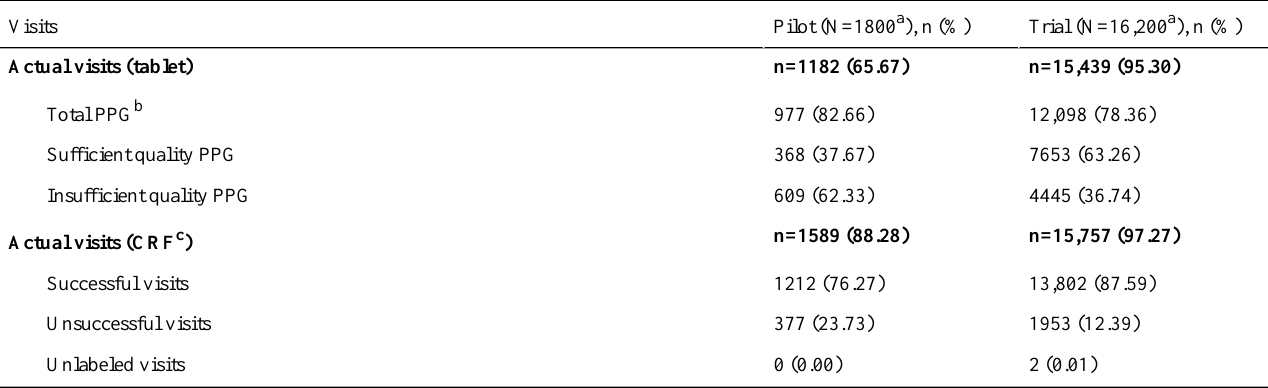
Table 1. Overview of the quantitative data from the 300 included children with respect to data completeness and photoplethymogram signal quality collected in the field during the pilot and